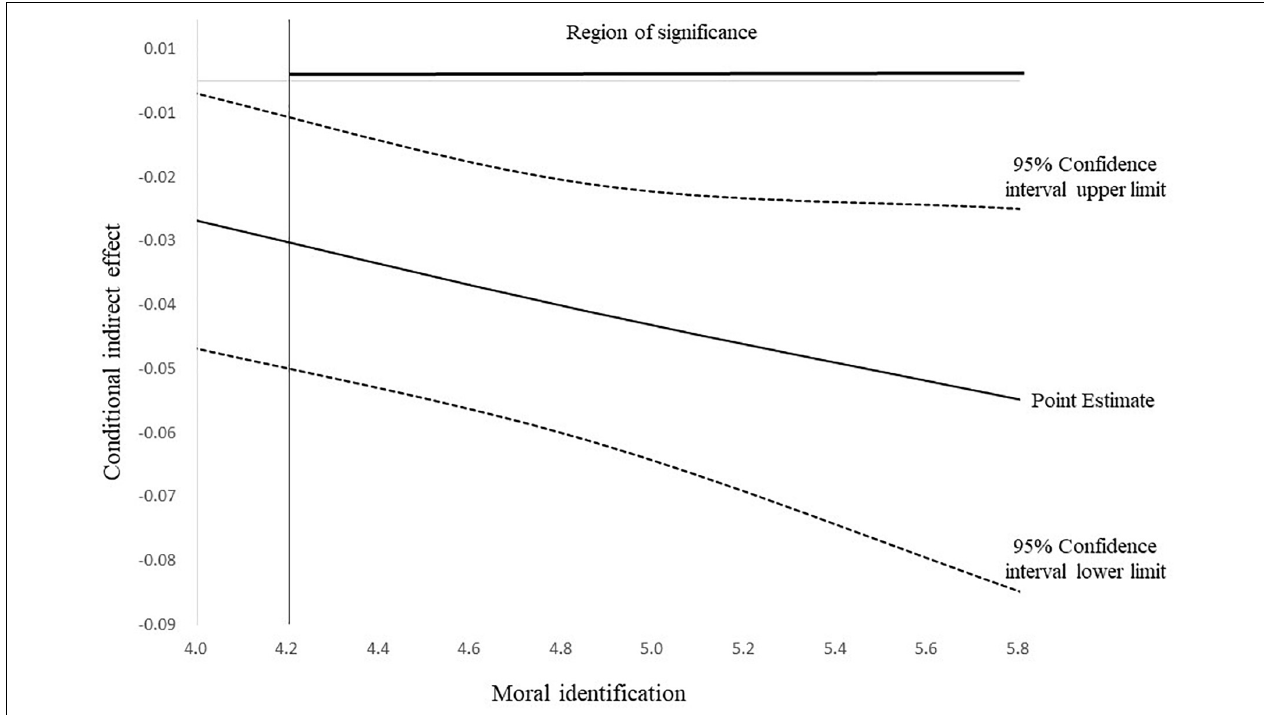
FIGURE 3 | The conditional indirect effect of CSR perception on surface acting via affective organizational commitment with moral identification as a first-stage moderator. Dashed lines represent upper and lower confidence limits (95% bootstrap confidence intervals).